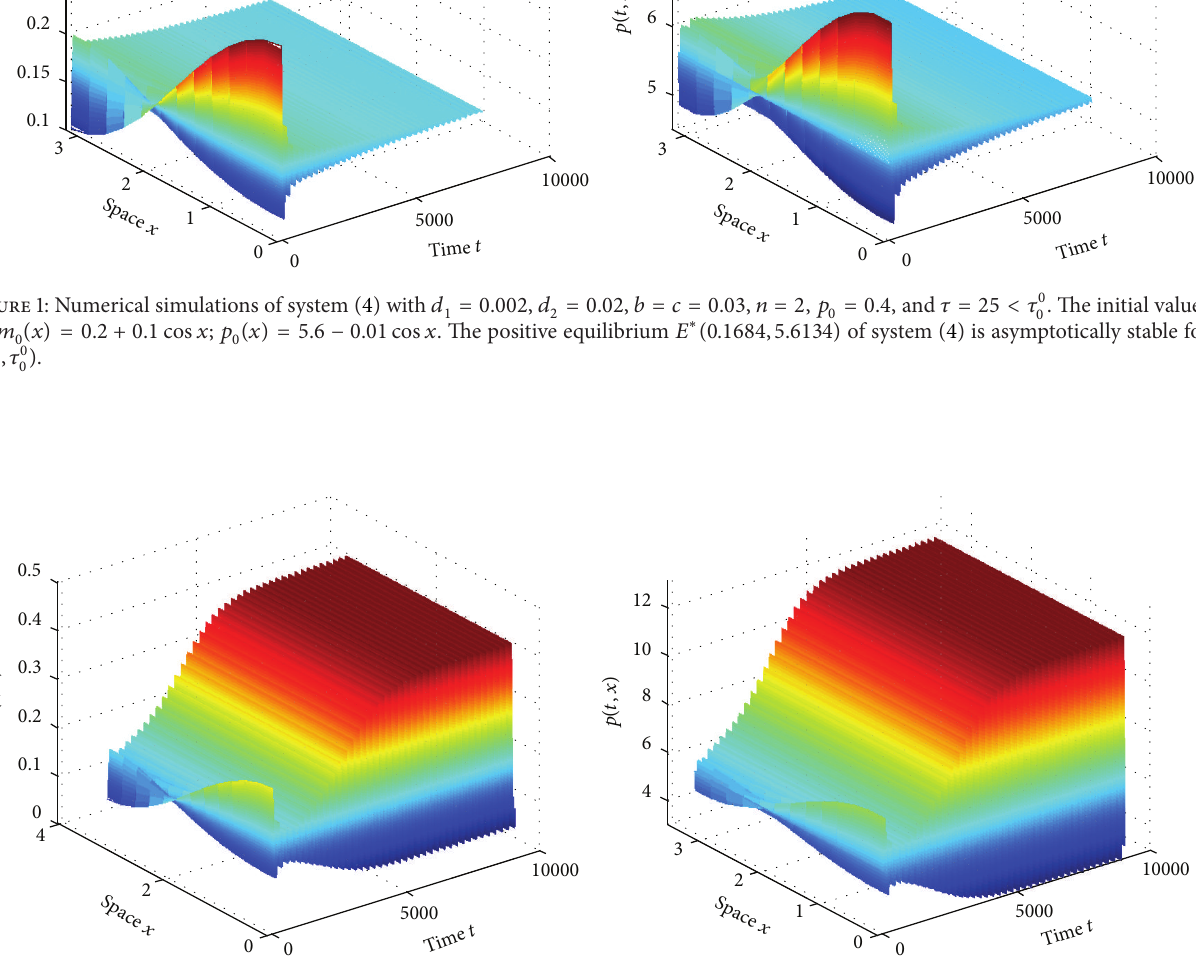
Figure 2: Numerical simulations system (4) with 𝑑 1 = 0.002 , 𝑑 2 = 0.02 , 𝑏 = 𝑐 = 0.03 , 𝑛 = 2 , 𝑝 0 = 0.4 , and 𝜏 = 30 > 𝜏 0 0 . The initial values are (𝑥) = 0.2 + 0.1 cos 𝑥 ; 𝑝 (𝑥) = 5.6 − 0.01 cos 𝑥 . The positive equilibrium 𝐸 ∗ (0.1684, 5.6134) of system (4) becomes unstable and there exist 𝑚 0 0 stable spatially homogeneous periodic